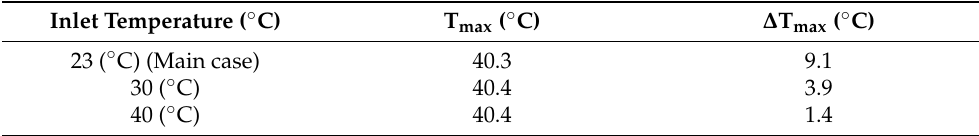
Table 6. The thermal performance of the system with various inlet